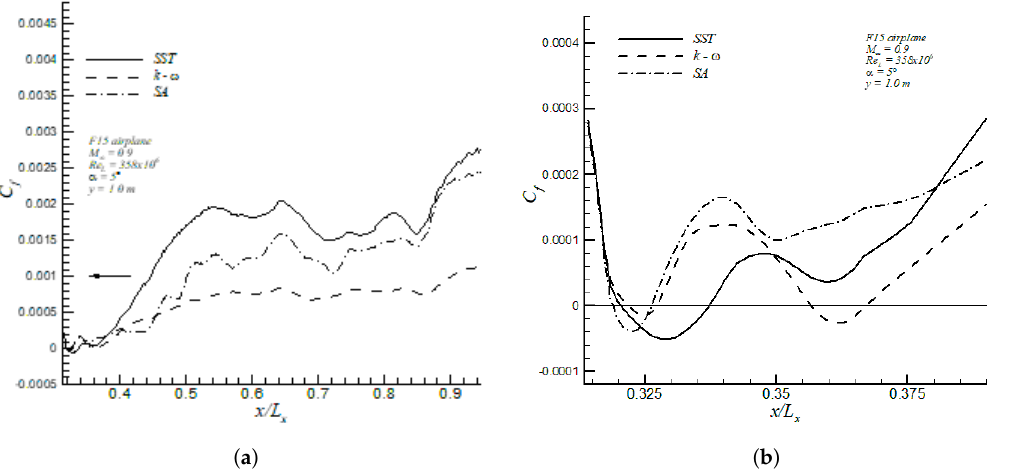
Figure 16. Skin friction coefficient in the upper surface of F15 at y / L y = 0.15 ( a ); and zoom of the separated flow zone ( b